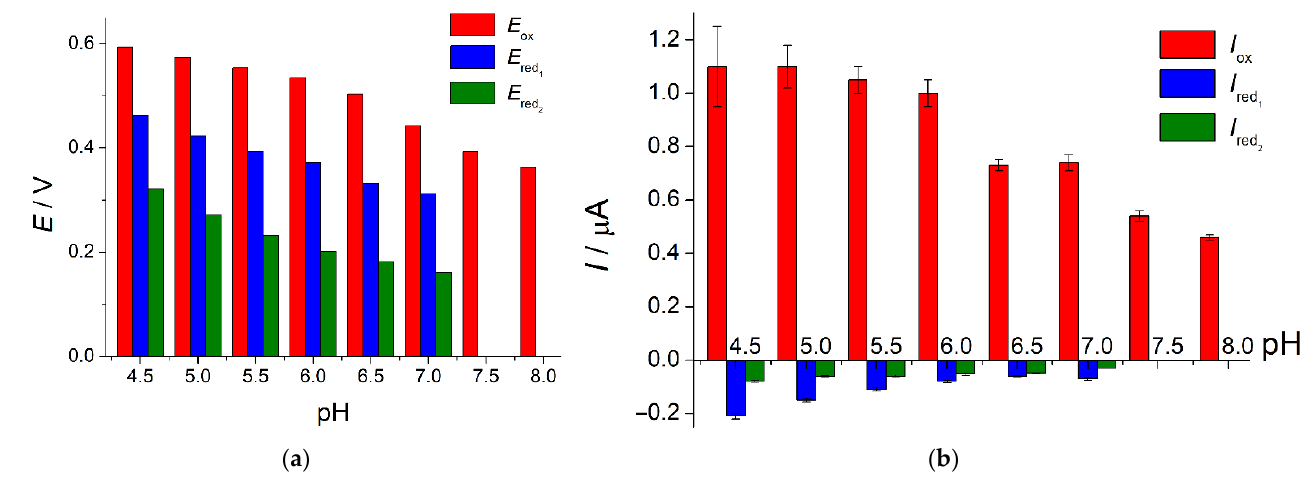
Figure 7. Effect of phosphate buffer pH on the voltametric characteristics of 50 µM indigo carmine at the SeO 2 –CPB/GCE: ( a ) the changes of the oxidation potential; ( b ) the changes of the oxidation currents.